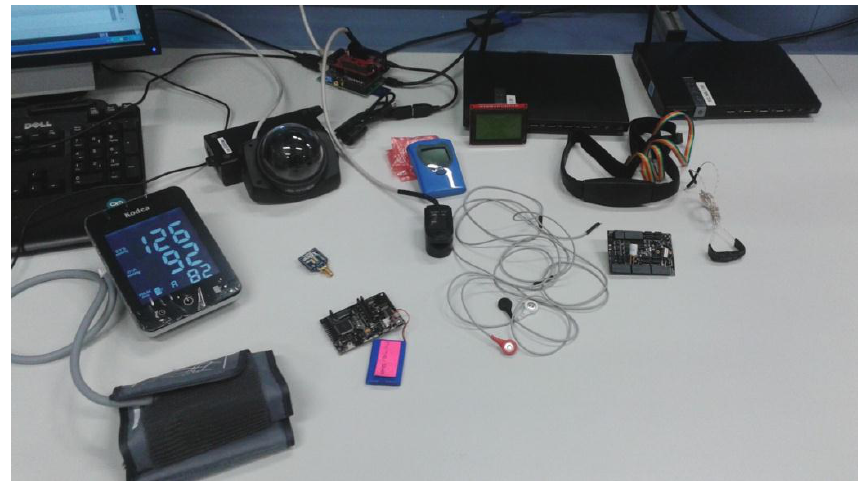
Figure 12. Infrastructure of the healthcare demonstrator: e -Health Sensor Platform V2.0., gas sensors kit and processing units.